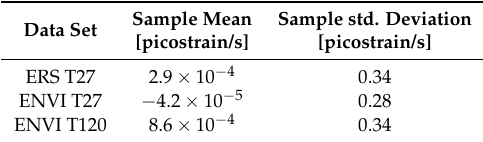
Table 3. Distribution parameters for differenced SqueeSAR and MST stack gradients for each satellite track.